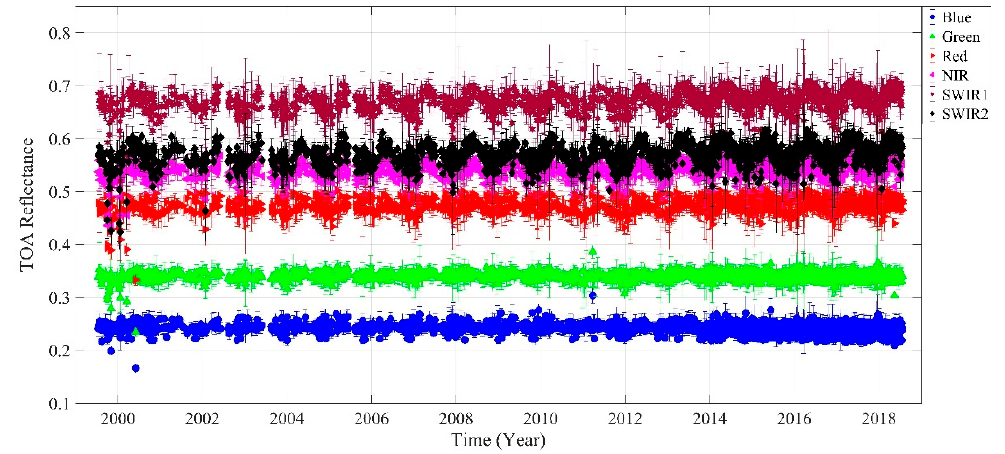
Figure 8. Lifetime OLI TOA Reflectance of Cluster 13 using Landsat 7, No BRDF Correction. Table 3. Comparison of K-Means Cluster 13 Statistics and Scene-Based Cluster 13 Statistics. Cluster 13 K Means Algorithm Selected Landsat 7